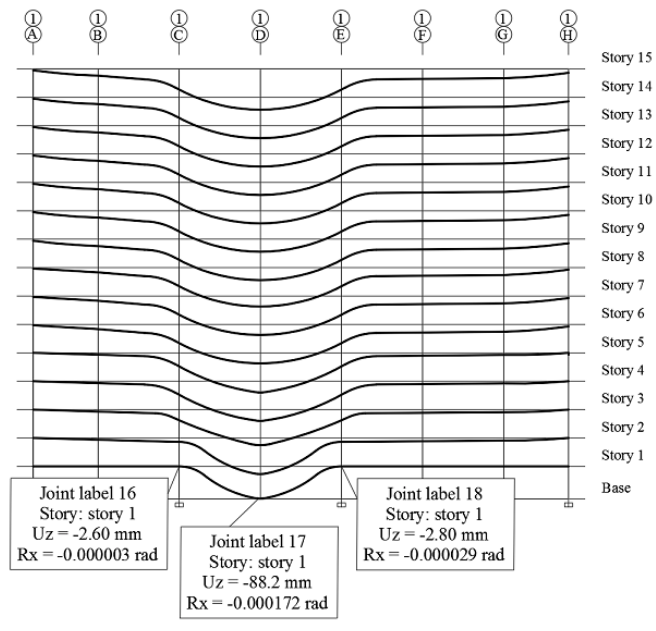
Figure 17. Displacement at the location of notionally removed column D1 when moment frames are located at perimeters and along grid lines B, C, D, E, F and G (non-linear dynamic analysis case